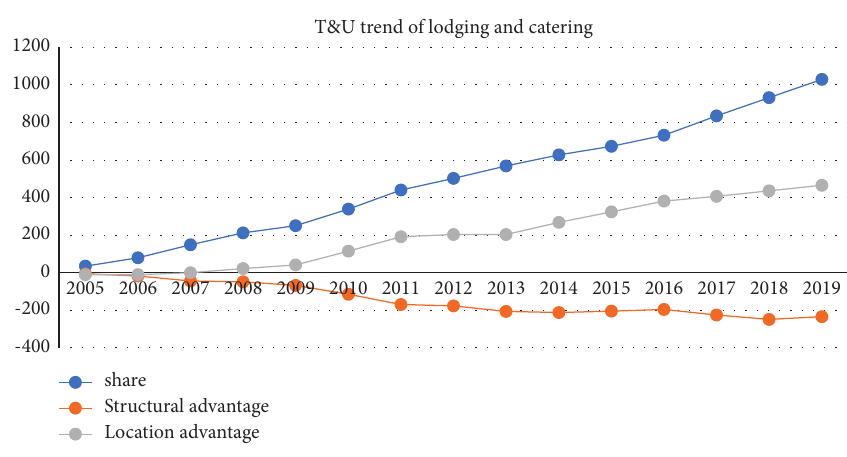
Figure 3: T&U trend of lodging and